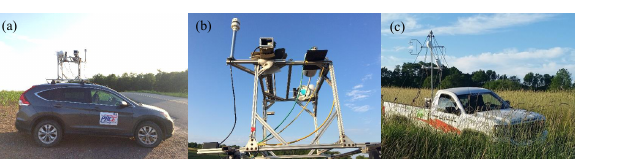
Figure 1. (a) The Princeton atmospheric chemistry experiment (PACE), (b) close-up of the PACE roof rack with instrumentation and (c) the mobile tower